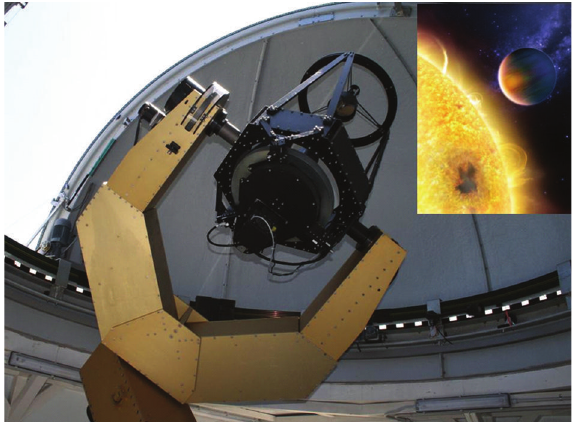
Figure 1: Robotic telescopes are one of the best tools for searching exoplanets.